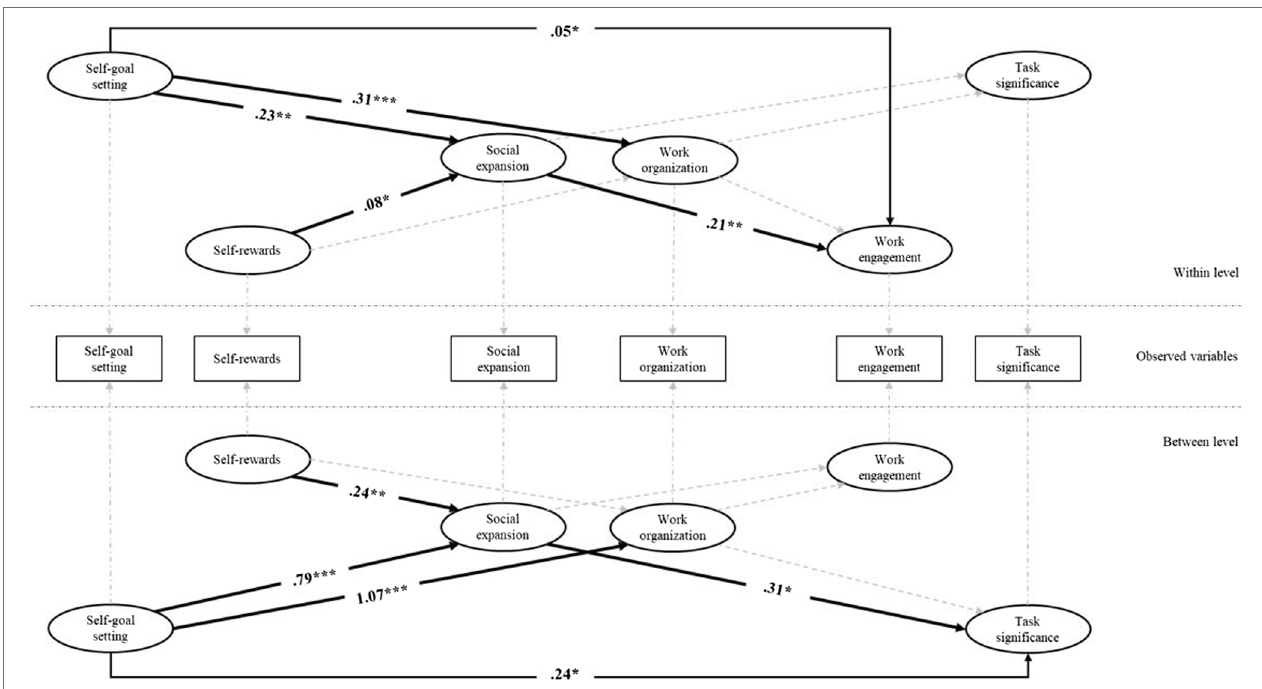
FIGURE 2 | Result of the multilevel model. Bold arrows represent significant paths. Non-standardized significant estimates are displayed. The results account for the role of number weekly remote working hours. Control variables (age and gender), related paths, and estimated paths from independent variables to outcome variables are not displayed for the sake of clarity. Only indirect paths that are significant are displayed. *** p ≤ 0.001, ** p ≤ 0.01, and * p ≤ 0.05.